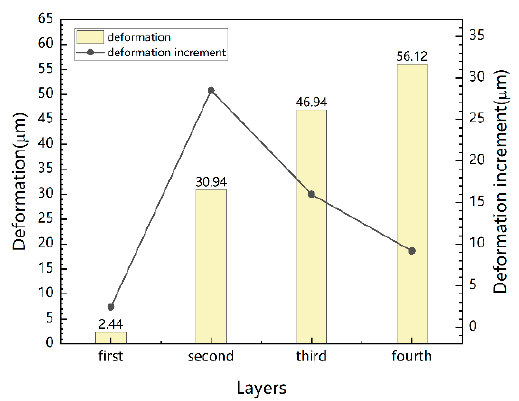
Figure 11. The deformation and its increment between different